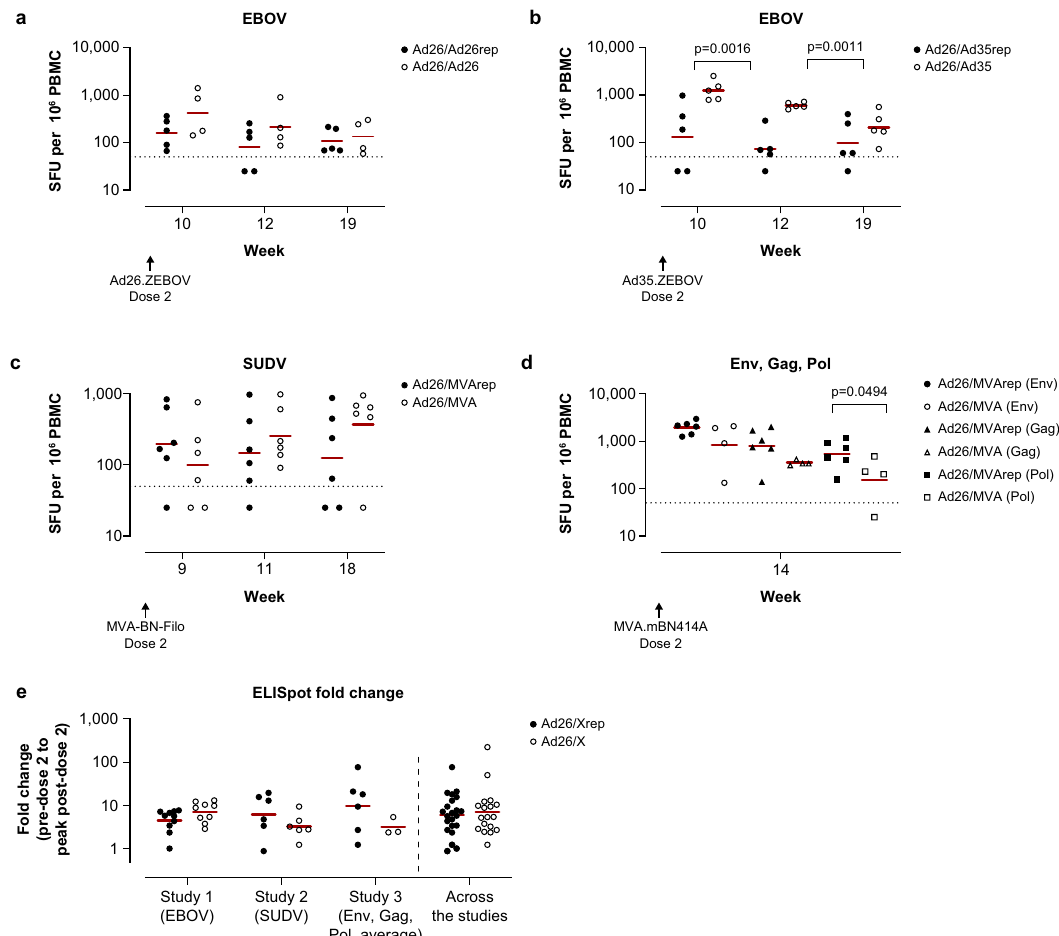
Fig. 5 Heterologous vectors boost Ad26 vaccine – induced cellular immune responses in the presence of pre-existing Ad26 immunity in cynomolgus macaques. IFN γ ELISpot responses in PBMC were determined as described in the Fig. 3 legend, with peptide pools for EBOV GP ( a , b ); SUDV GP ( c ); and HIV Env, Gag, and Pol ( d ). Shown are background-subtracted values per animal of animals receiving an Ad26/Ad26 ( a ) or Ad26/Ad35 ( b ) regimen encoding EBOV GP; Ad26 encoding SUDV GP and MVA encoding SUDV GP, EBOV GP, MARV GP ( c ); or Ad26/MVA encoding Env, Gag, and Pol of HIV ( d ). Animals that had received an Ad26 vaccine during the A-series are annotated as Ad26/Ad26rep ( a ), Ad26/Ad35rep ( b ), or Ad26/MVArep ( c , d ). In ( a – d ), the dotted line represents the assay threshold of 50 SFU/10 6 PBMC. In ( e ), the fold-change is depicted and corresponds to the change in responses comparing pre – dose 2 to peak response post – dose 2 per animal. Ad26/Xrep refers to animals vaccinated in the A-series, and Ad26/X refers to animals that were not vaccinated during the A-series. The red horizonal line is the geometric mean. Pairwise comparison of the difference between pre-exposed animals and unexposed animals per time point was performed for data in ( a – d ), summarized in Supplementary Table 1. An ANOVA was performed over the fold-changes per study and across the 3 studies over the data shown in ( e ), summarized in Supplementary Table